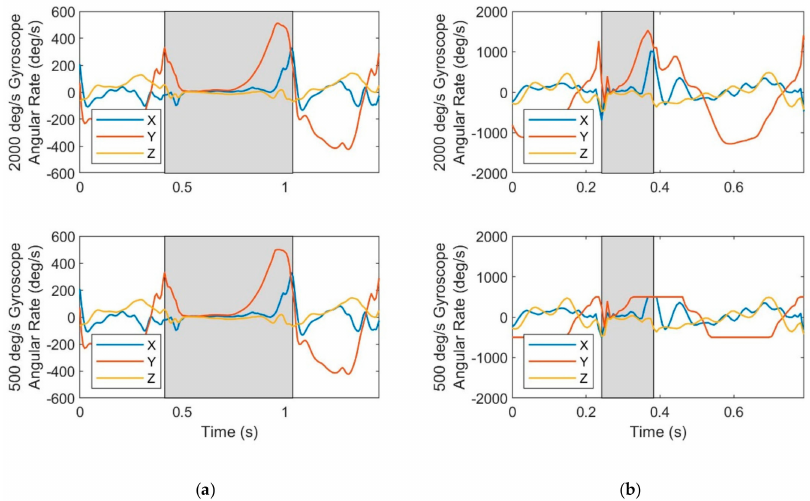
Figure 8. E ff ect of gyro range limits on angular velocity for a sample ( a ) walking trial (mean speed 1.4 m / s) and a sample ( b ) running trial (mean speed 5.8 m / s). Angular velocity data is saturated when the slope is zero as is most apparent for the Y -axis angular velocity of the 500 deg / s gyro for the running trial. Shaded areas indicate stance phases.